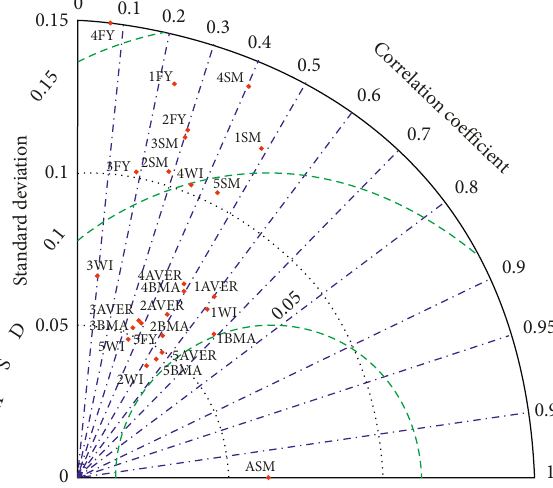
Figure 6: Taylor diagram for five